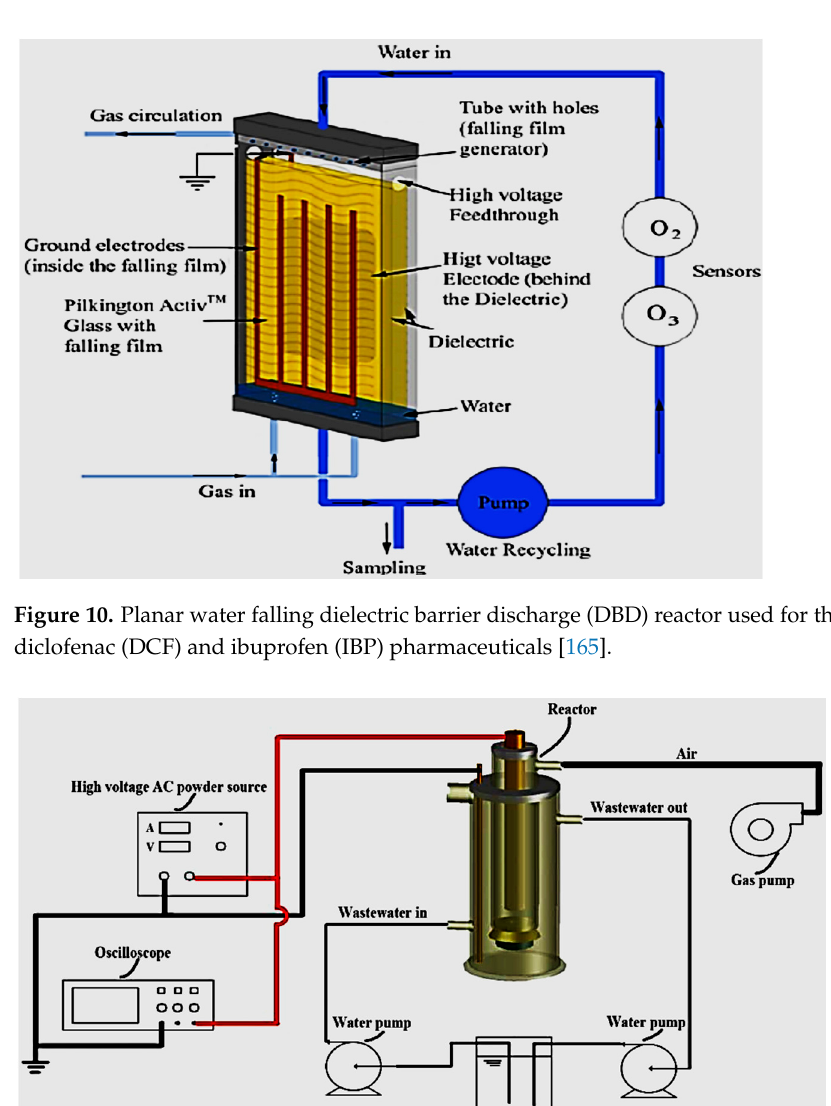
Figure 12. Dielectric barrier discharge (DBD) experimental system used for the decomposition of norfloxacin [167]. An extended investigation on the influences of nitrite on paracetamol degradation in dielectric barrier discharge reactor shown in Figure 13 was conducted by Pan and Qiao [50].